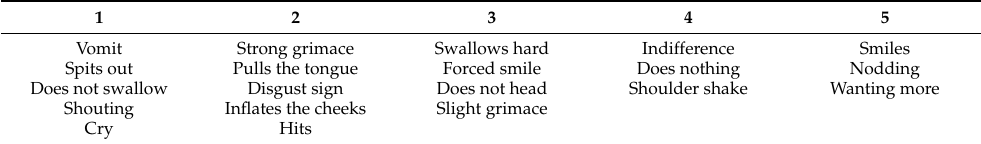
Table A2. Hetero-Evaluation by a Third